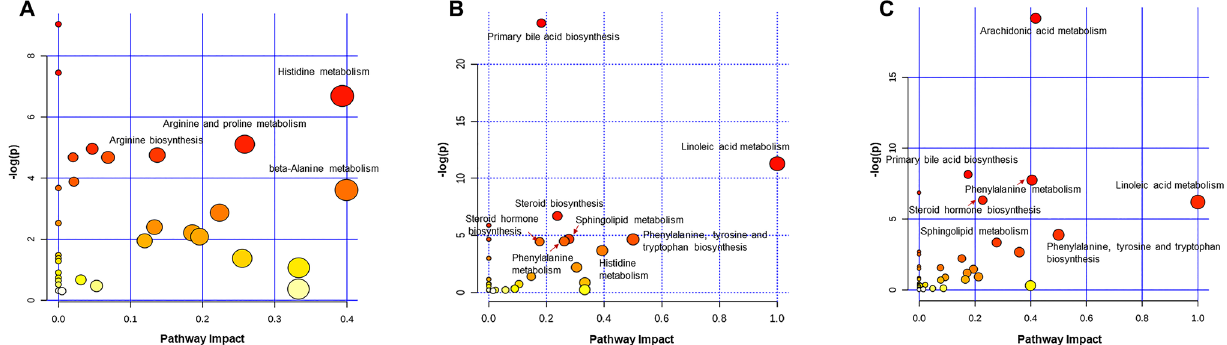
Figure 4. Summary of pathway analysis with MetaboAnalyst. ( A – C ) Metabolic pathway analysis of the feces in E ( A ), E + C ( B ), and E + P ( C ) were performed with significantly changed metabolic features ( P < 0.05). Potential target pathways were labeled based on the impact-value threshold (0.10) and P -value (0.05). Ctrl control group, E emphysema group, E + C emphysema with high-cellulose diet group, E + P emphysema with high-pectin diet group.